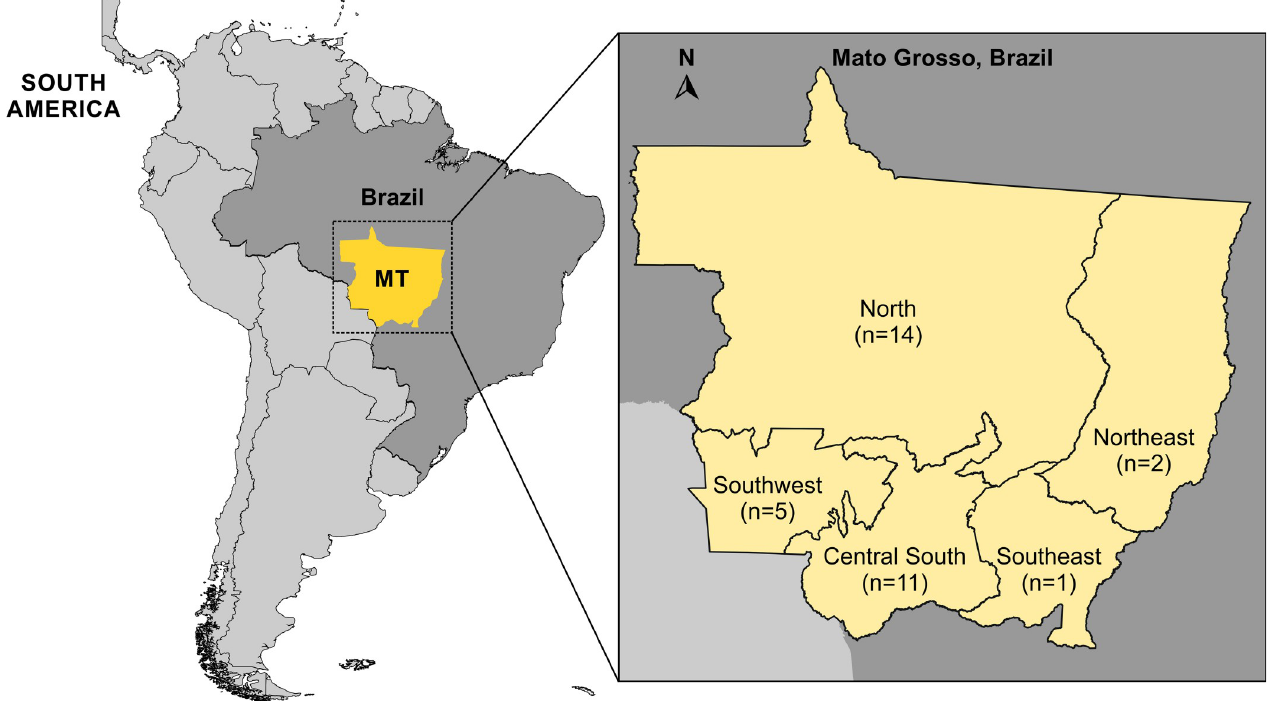
Fig 1. South America map showing sampling localities in Middle-West Brazil and total number of clinical cases of paracoccidioidomycosis caused by Paracoccidioides lutzii assessed in Mato Grosso, Brazil. The South America map was treated using the vector graphics editor Corel Draw X8.